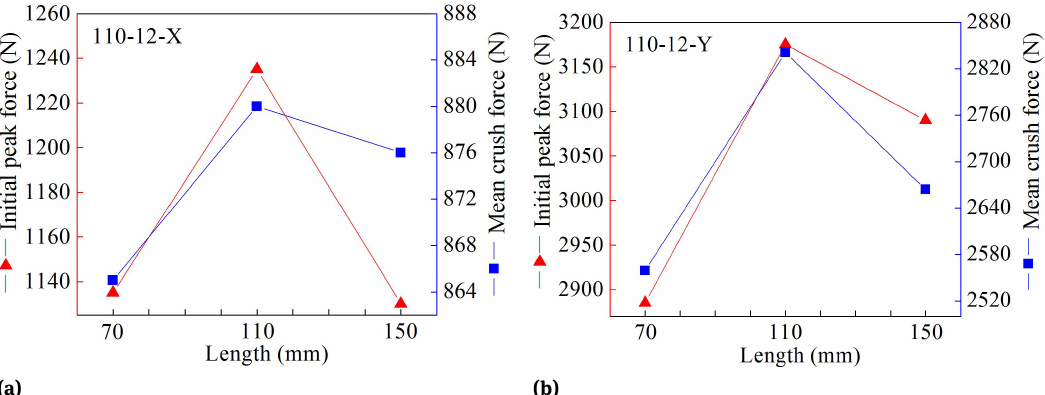
Figure 15: Initial peak force and mean crush force of regular pentagon paper corrugation tubes with different tube lengths: (a) tubes along X direction; (b) tubes along Y direction